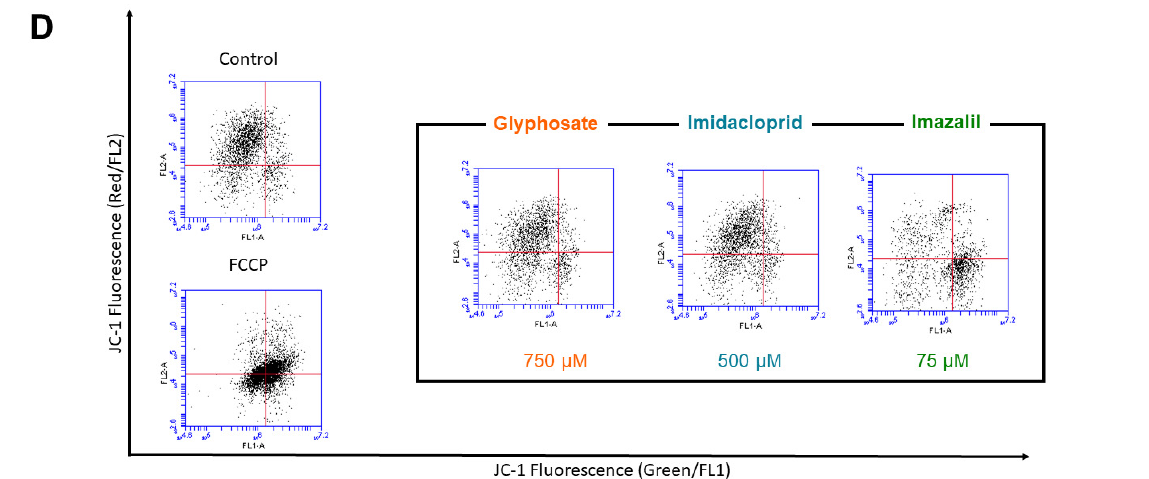
Figure 5. Assessment of changes on mitochondrial membrane potential (MMP) in Caco-2 ( A , B ) and HepG2 ( C , D ) cells exposed to GLY, IMD, and IMZ for 24 h, at indicated concentrations. Flow cytometry dot plots of Caco-2 ( A ) and HepG2 ( D ) cells exposed to the highest concentrations of each pesticide. The calculated FL2/FL1 ratio for Caco-2 ( B ) and HepG2 ( C ) cells exposed to 3 different concentrations of each pesticide, and the percentage of FL2/FL1 rate decay comparing to respective control. Results are presented as mean ± SD. Significant statistical differences between the control and samples are denoted as “*” when p < 0.05.